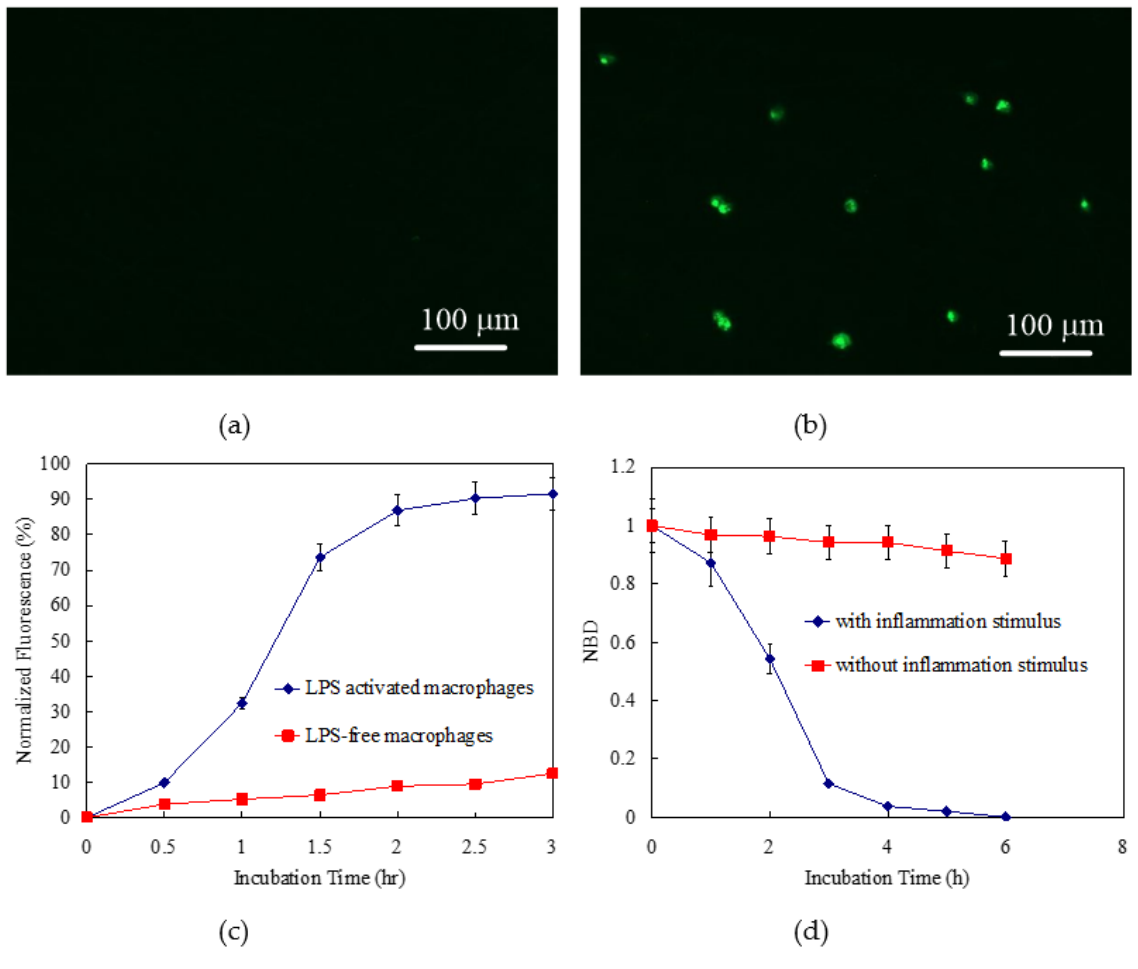
Figure 7. Fluorescent microscopy images of macrophages ( a ) without and ( b ) with LPS activation at 5 μ g mL − 1 of stimulation concentration. ( c ) Normalized fluorescence plotted as function of incubation time during LPS-initiated inflammation. ( d ) Normalized optical density (NBD) of SA culture media at 600 nm plotted in term of incubation time in the presence of chip with and without inflammation triggering. Data are presented as mean ± SD; p < 0.05.